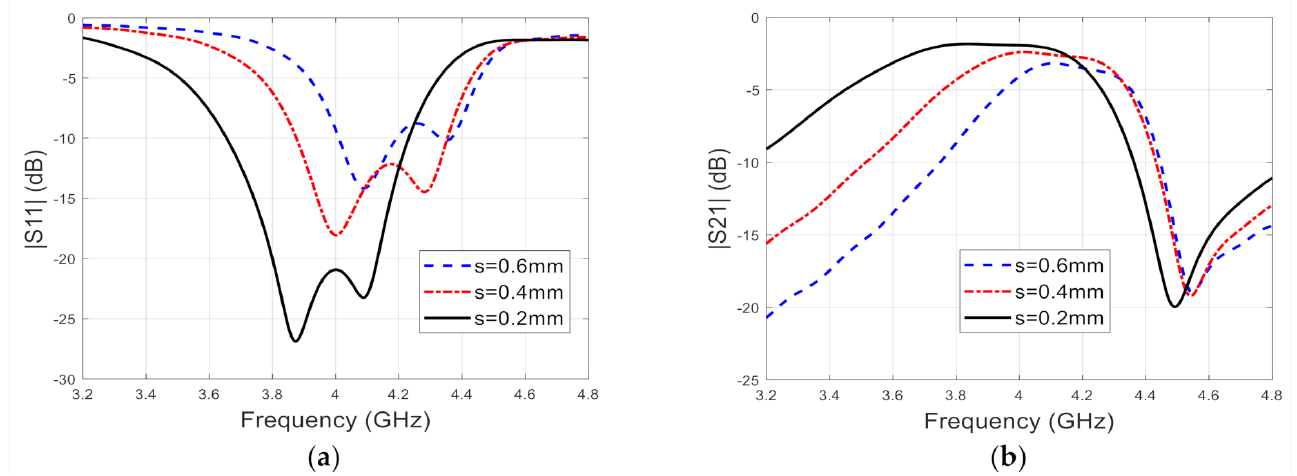
Figure 7. Simulated scattering parameters of the proposed SL-MMR-based microwave filter without the parasitic elements at L = 8.8 mm and different values of parallel lines separation: ( a ) reflection coefficient; and ( b ) the transmission